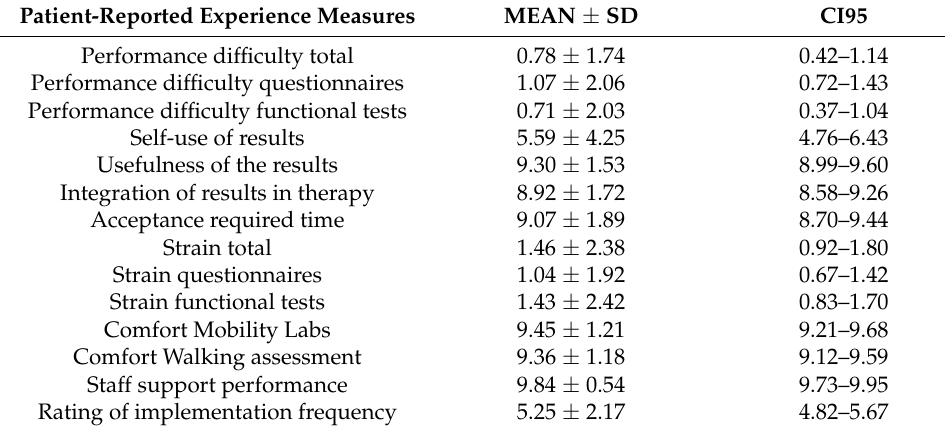
Table A1. Detailed description of the patient-reported experience